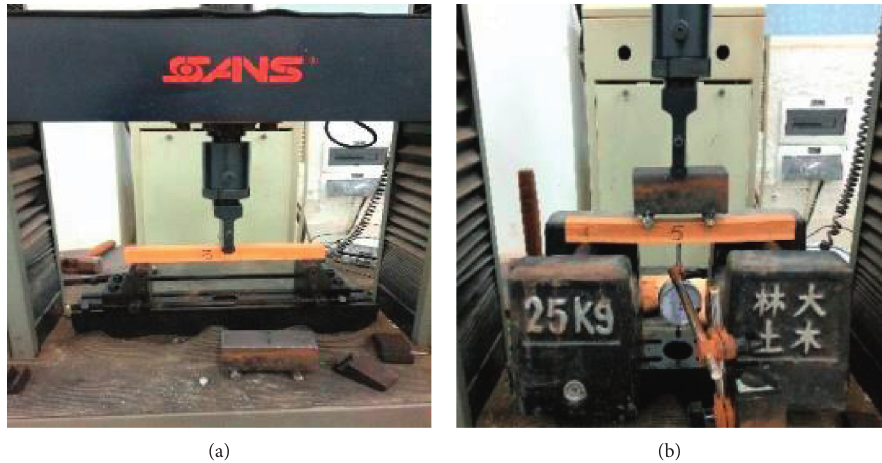
Figure 3: Apparatus testing in bending. (a) Apparatus testing in bending strength. (b) Apparatus testing in bending modulus.